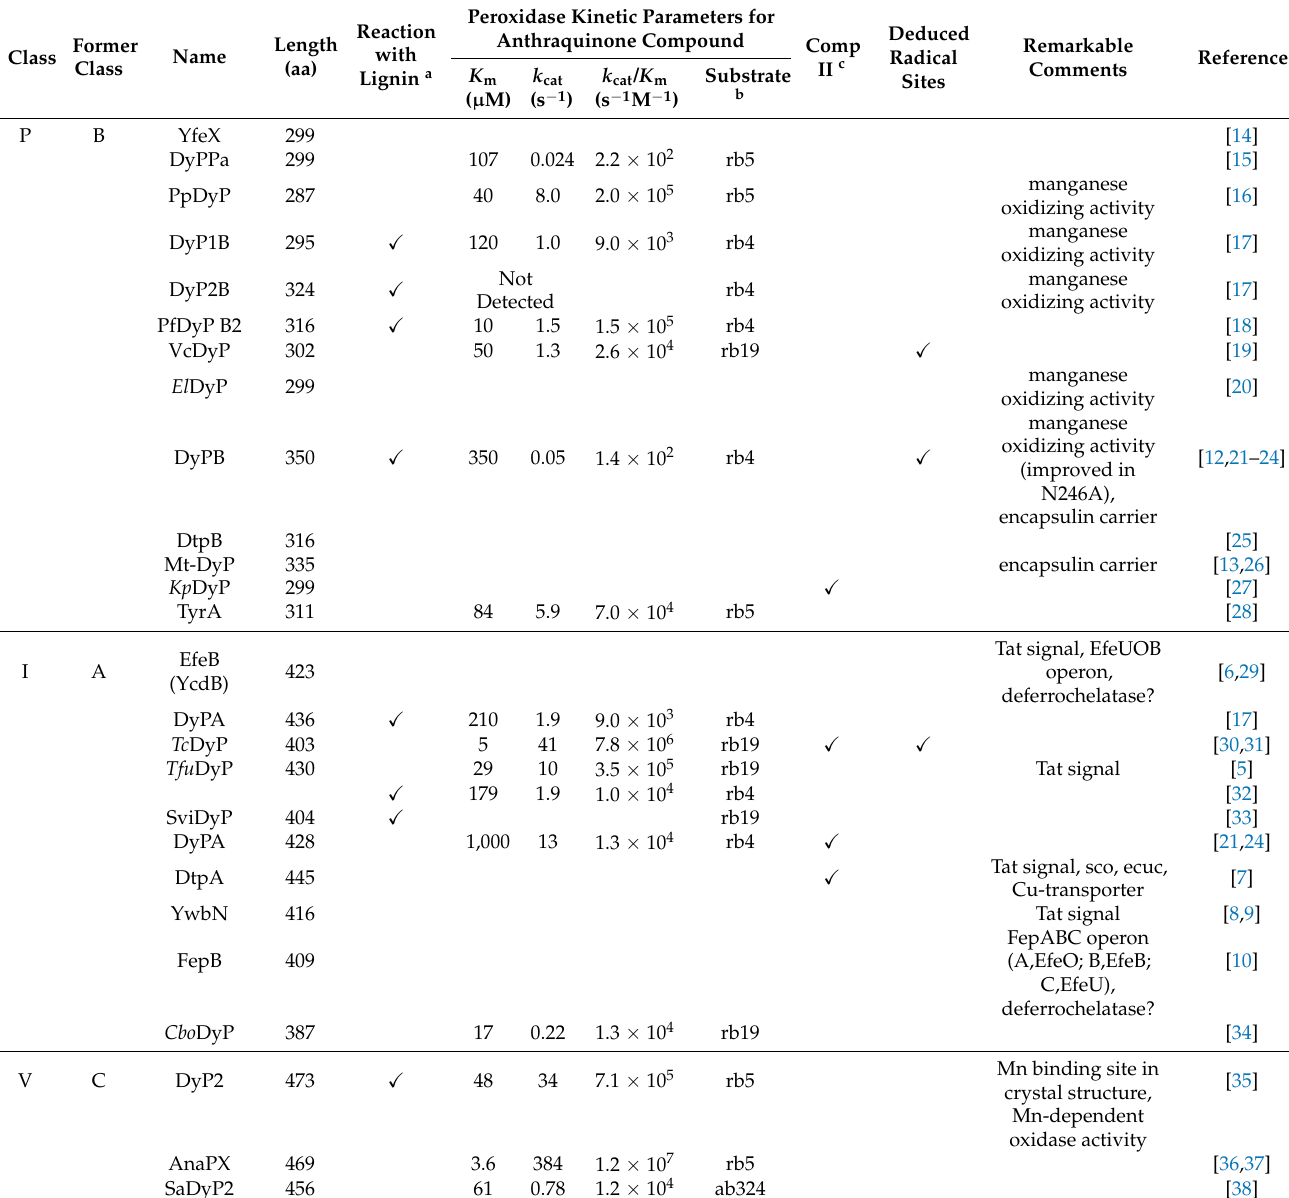
Table 1. Characteristics of representative DyP-type peroxidase from classes P, I, and